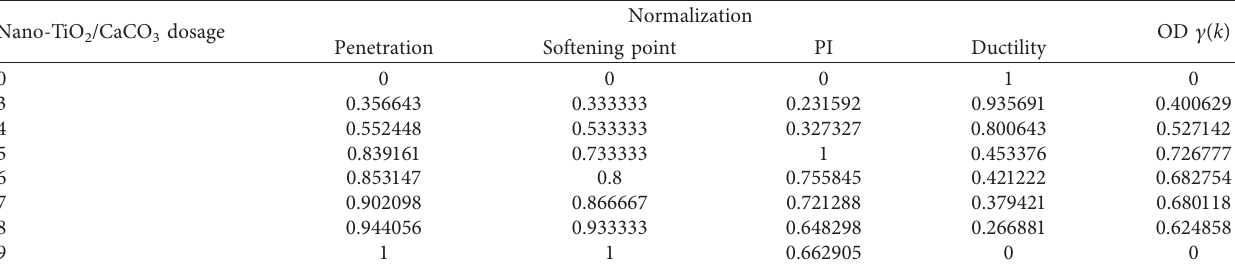
Table 4: Technical properties of nano-TiO